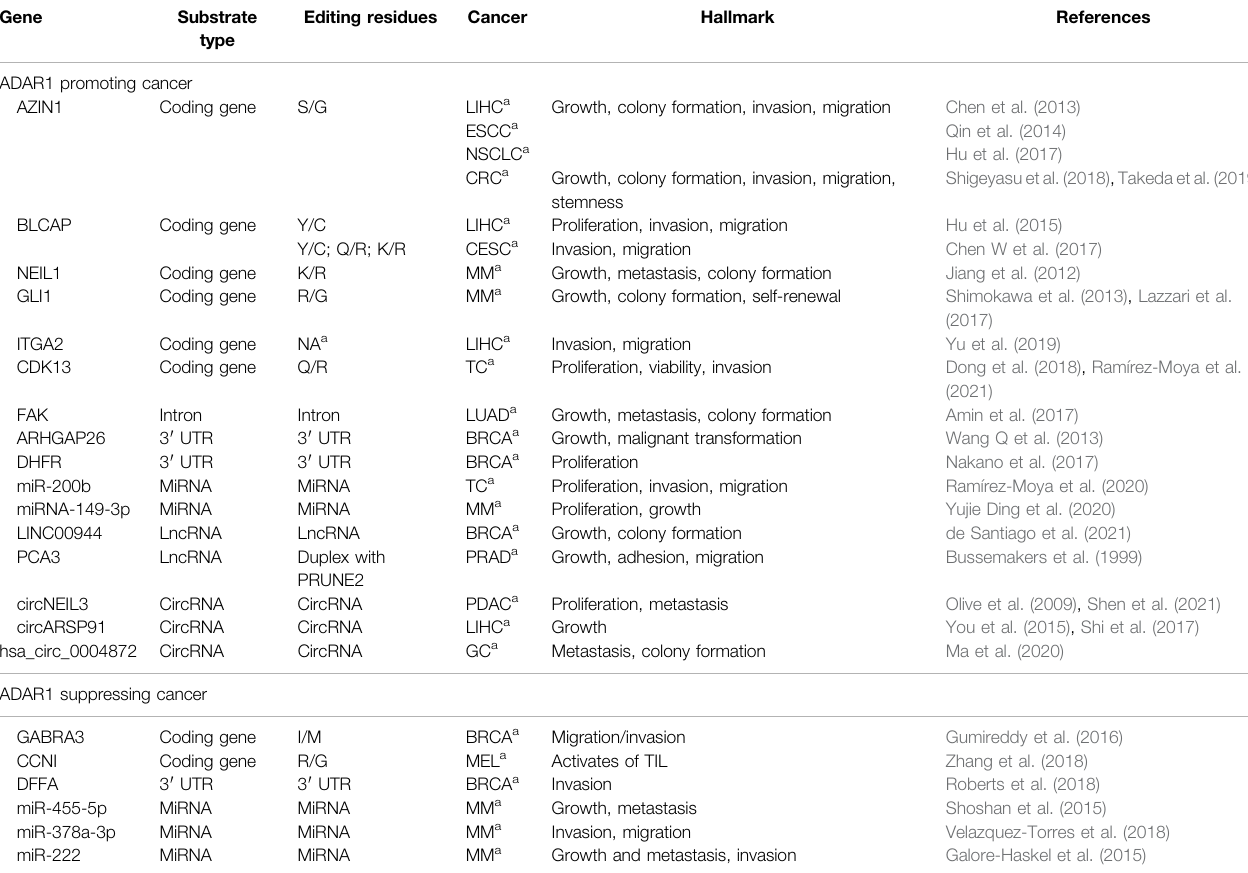
TABLE 1 | ADAR1 edits speci fi c substrates involved in cancer progression.